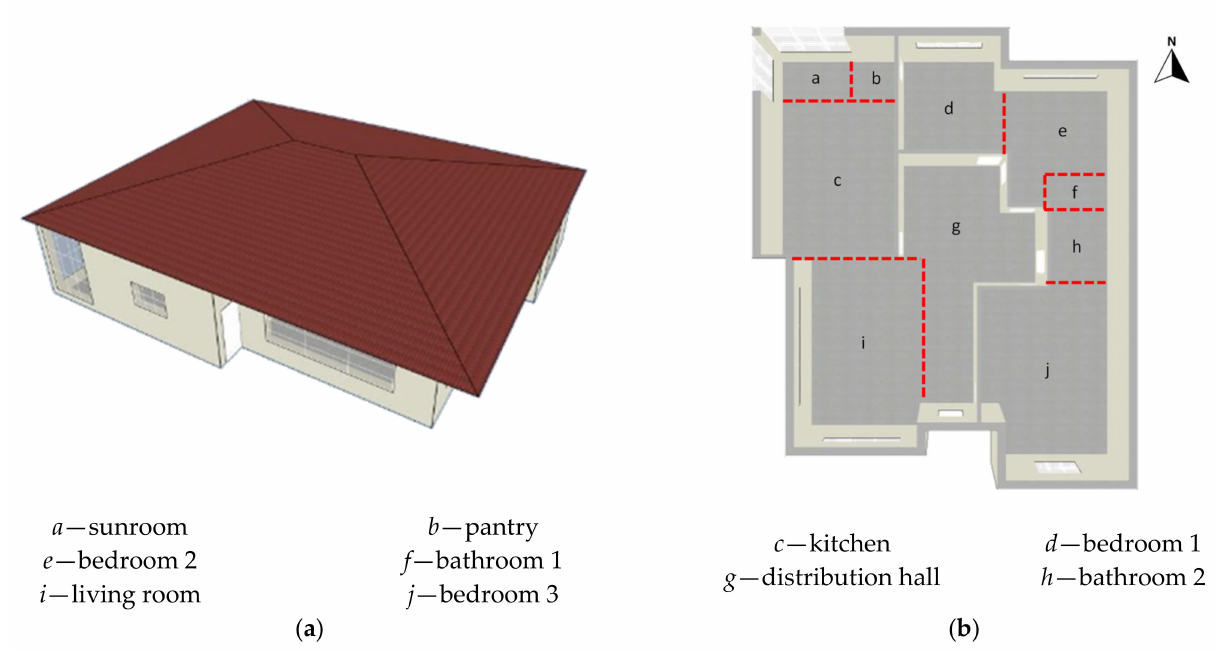
Figure 5. Rendered images of the case study building: ( a ) 3d model; ( b ) ground floor